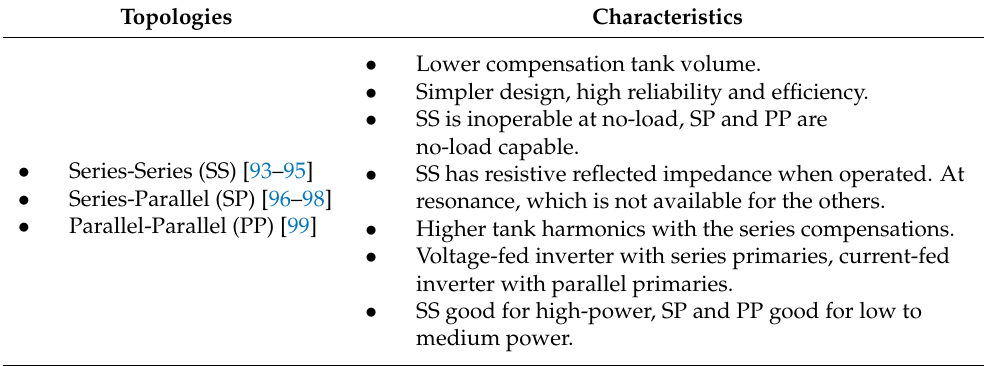
Table 2. Basic LC Compensations in